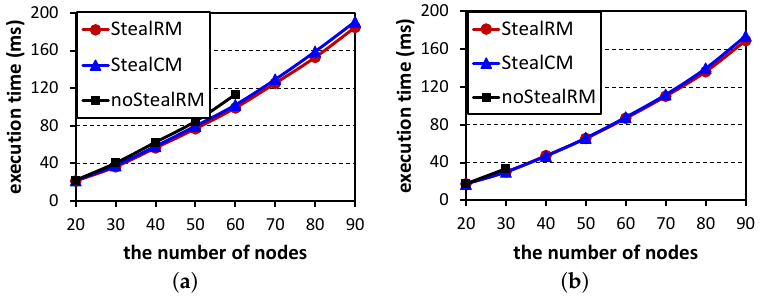
Figure 9. Average execution time. ( a ) M = 6, U = 0.5, ρ = 0.3; ( b ) M = 9, U = 0.5, ρ = 0.3.